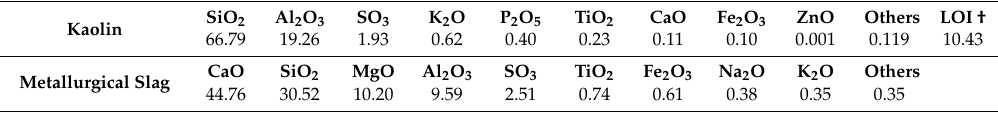
Table 5. XRF analysis (wt.%) of Tizayuca kaolin and metallurgical slag. Kaolin